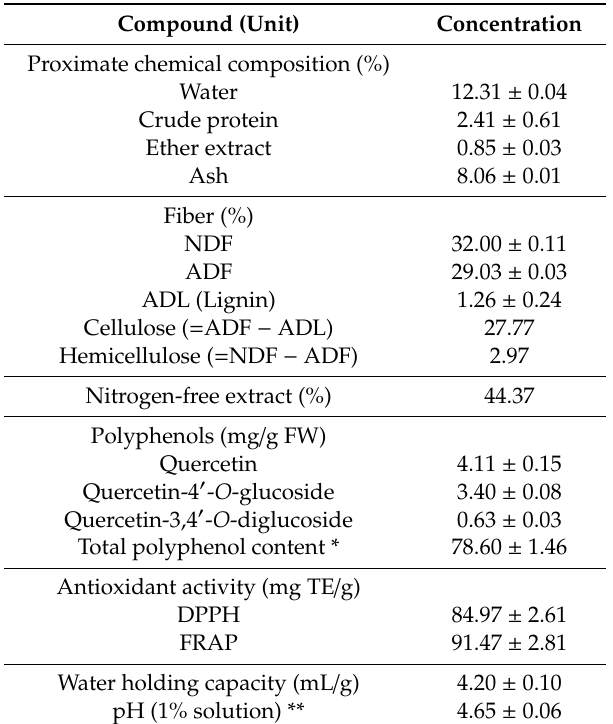
Table 1. Basic chemical composition of onion peel powder